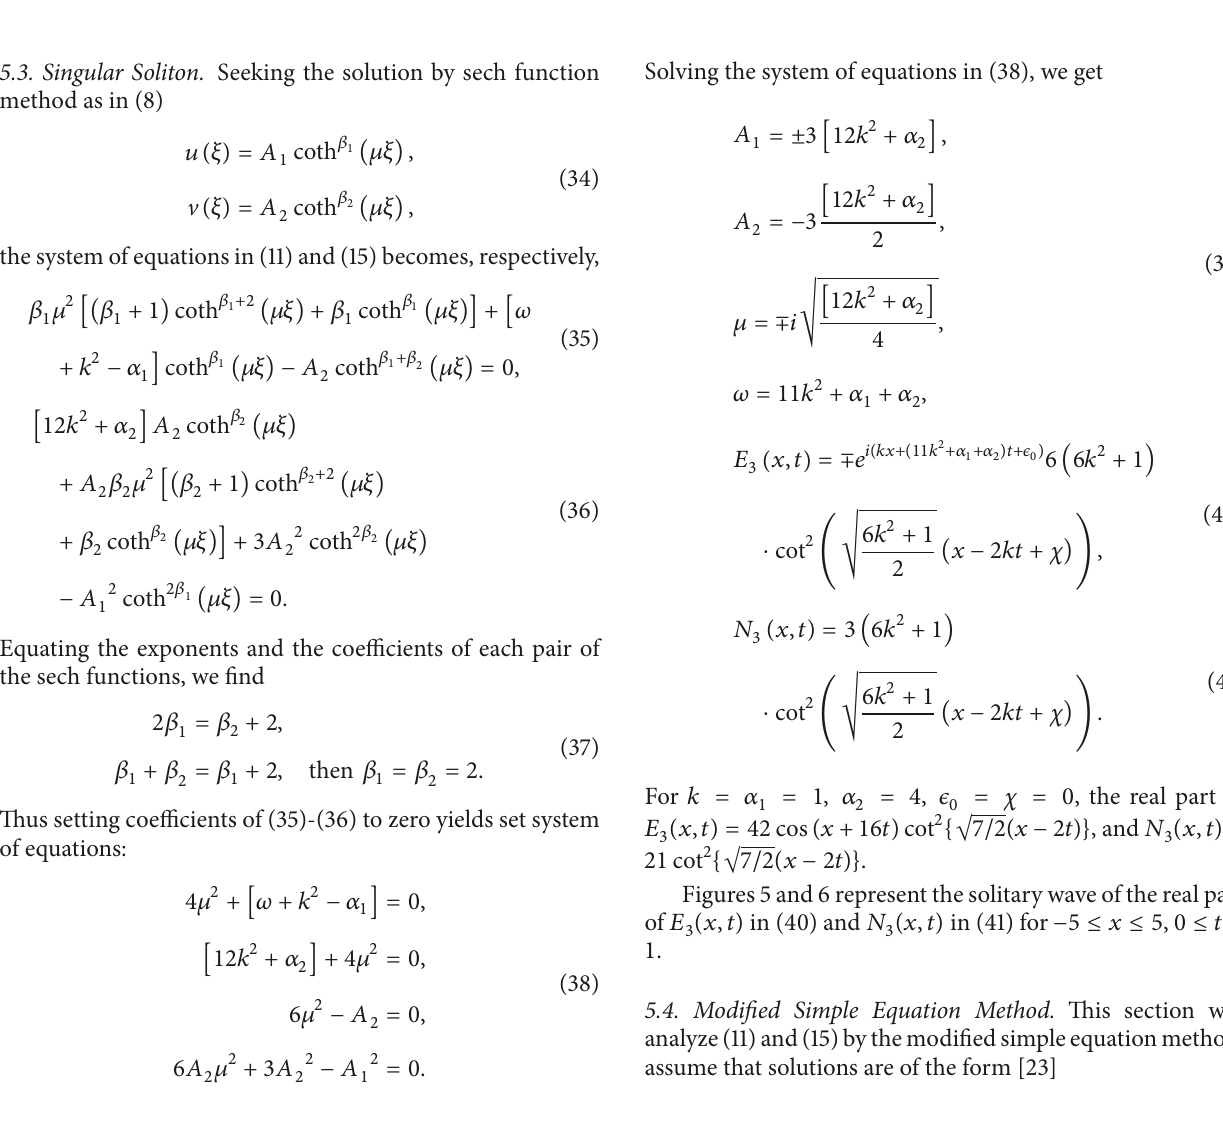
Figure 4: The solitary wave 𝑁 2 (𝑥, 𝑡) in (33) for −5 ≤ 𝑥 ≤ 5 , 0 ≤ 𝑡 ≤ 1 .